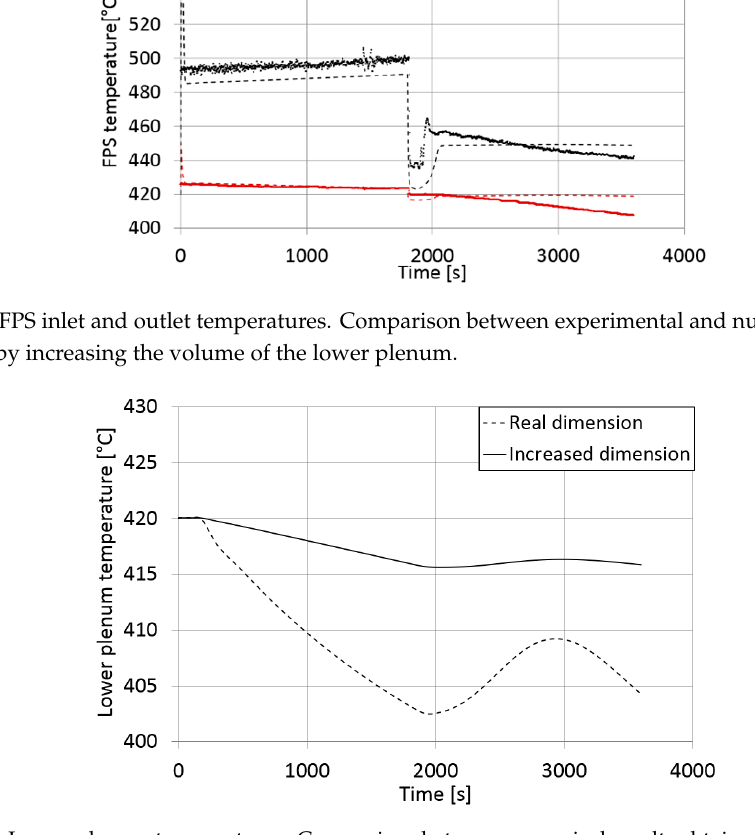
Figure 10. Lower plenum temperatures. Comparison between numerical results obtained by simulating the lower plenum with the increased volume and real size.